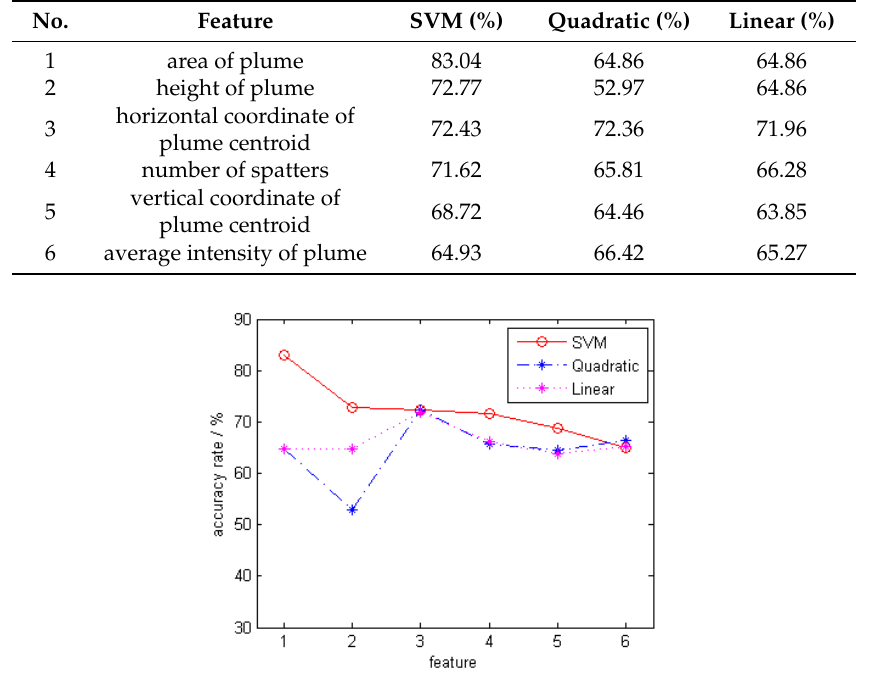
Figure 7. The classification results of various methods.